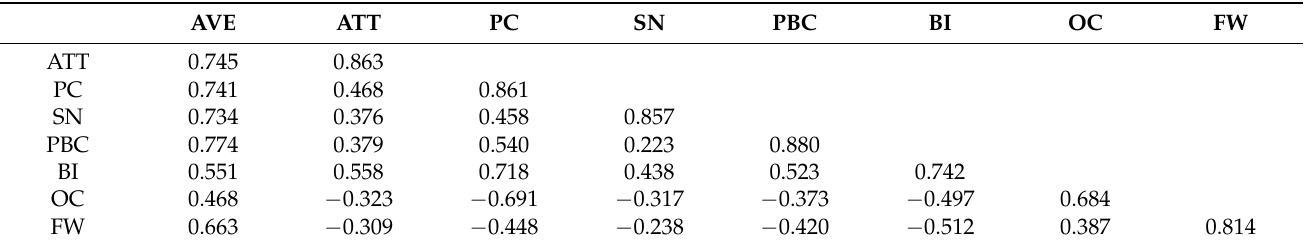
Table 3. Discriminant validity for the measurement model.